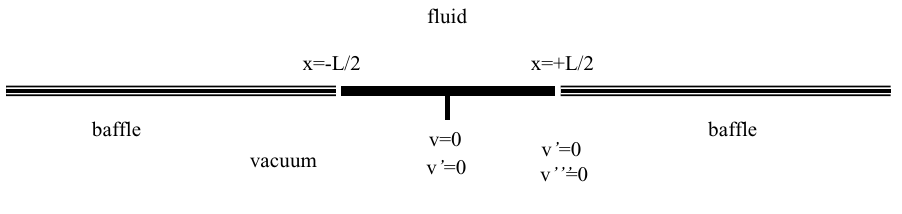
Fig. 5. Center-clamped strip